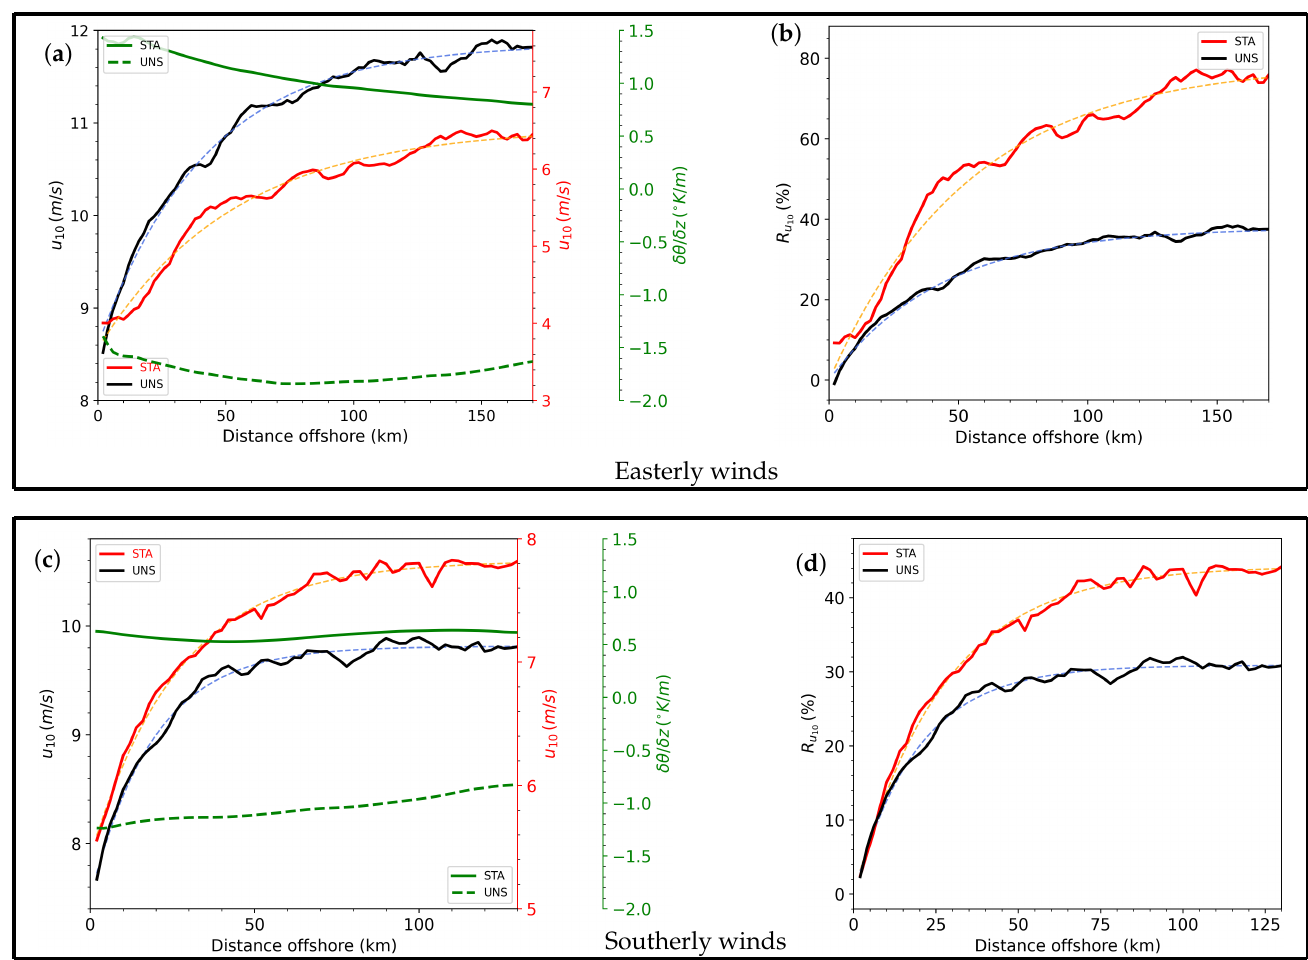
Figure 13. ( a , b ): Horizontal wind speed gradients ( a ) and normalised wind speeds ( b ) for stable (solid red) and unstable (solid black) cases from the “INCS” class for easterly winds. ( c , d ): The same as ( a , b ) for southerly wind directions. In ( a , c ) stable cases (red curves) refer to the scale of the right vertical axis (red) and unstable cases to the scale of left vertical axis (black). Green curves represent thermally stable (solid line) and unstable (dashed line) conditions and refer to the extra green scale on the right. The blue and orange dashed lines refer to the fitted empirical